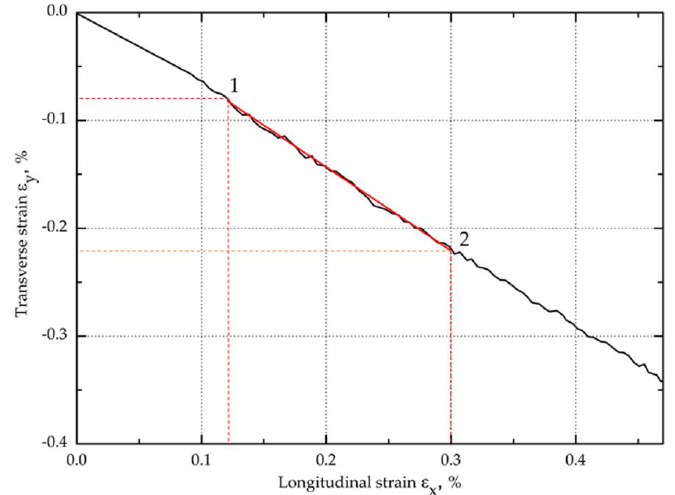
Figure 9. Example diagram of longitudinal strain vs. transverse strain obtained from digital image correlation.